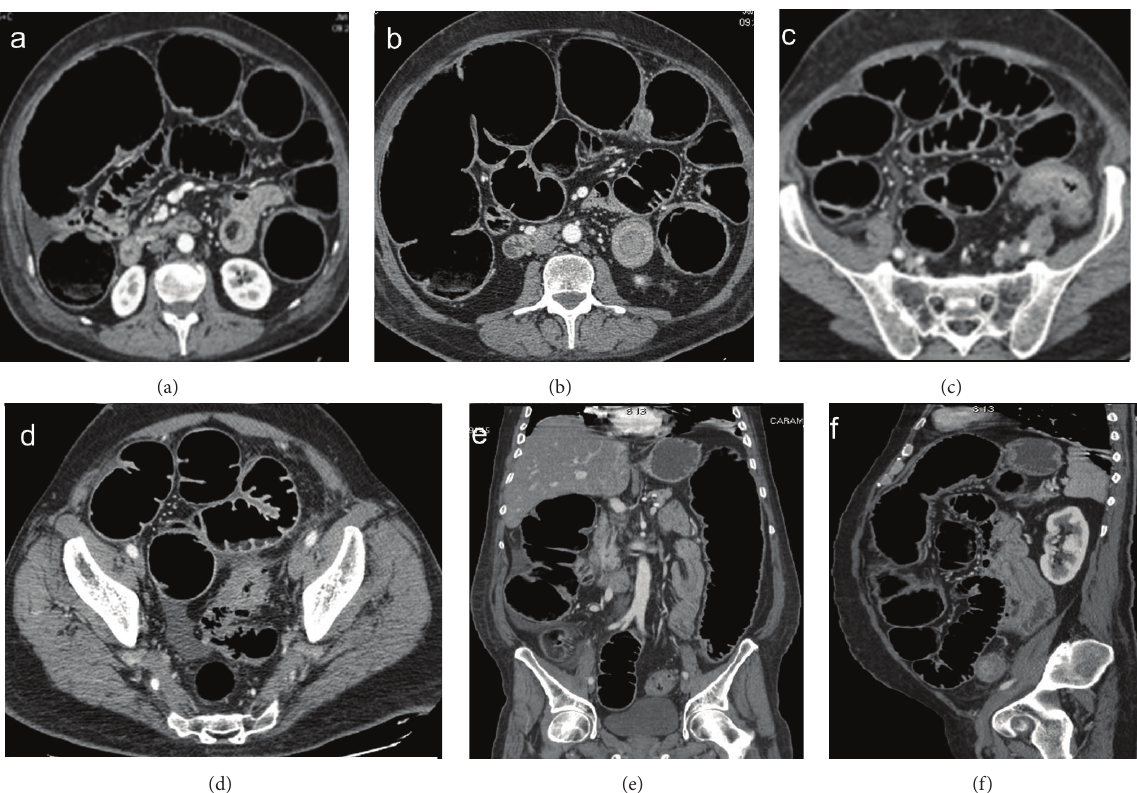
Figure 9: Enteroenteric (ileoileal) intussusception secondary to colic obstruction caused by a sigmoid cancer. Intussusception appears as a small target mass (a, b) in a condition of intestinal obstruction with massive small and large bowel dilatation, due to stenosing sigmoid cancer (d). Coronal (e) and sagittal (f) reformatting better depict the site and the extent of intussusception.